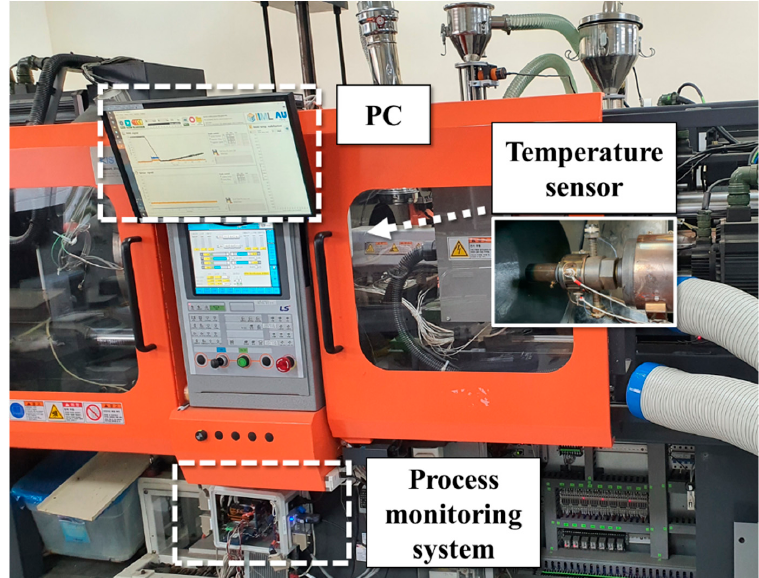
Figure 3. Measurement system.